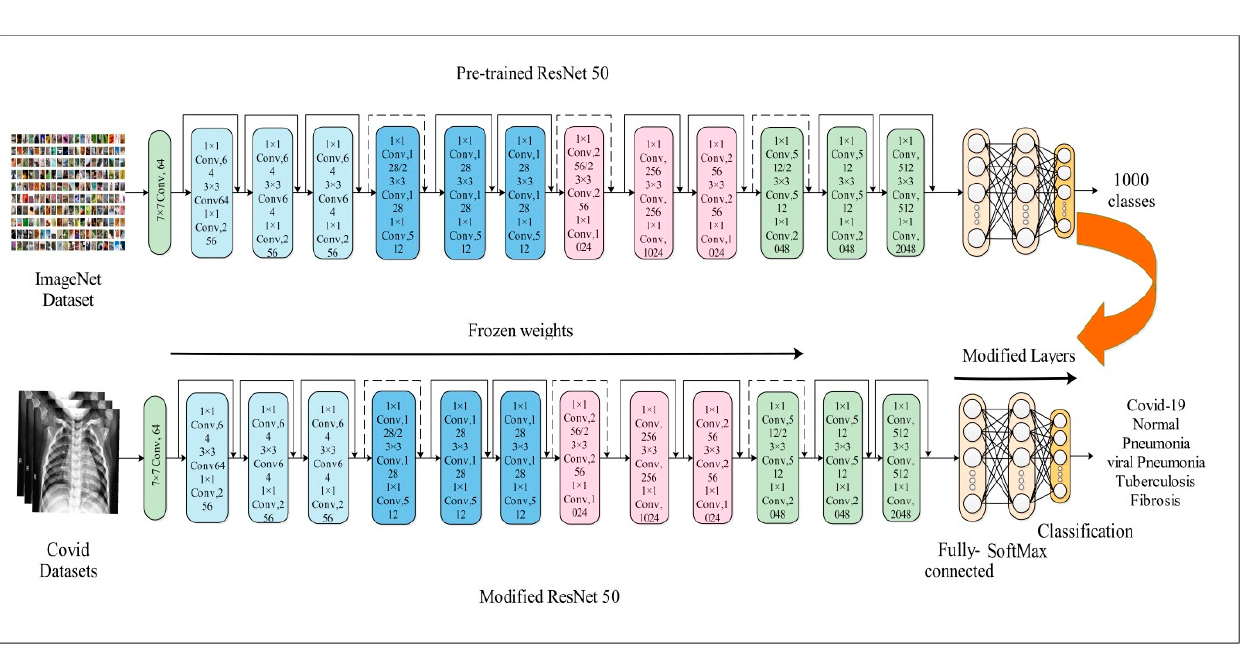
Figure 4. Modified architecture of ResNet50 using freezing weights.